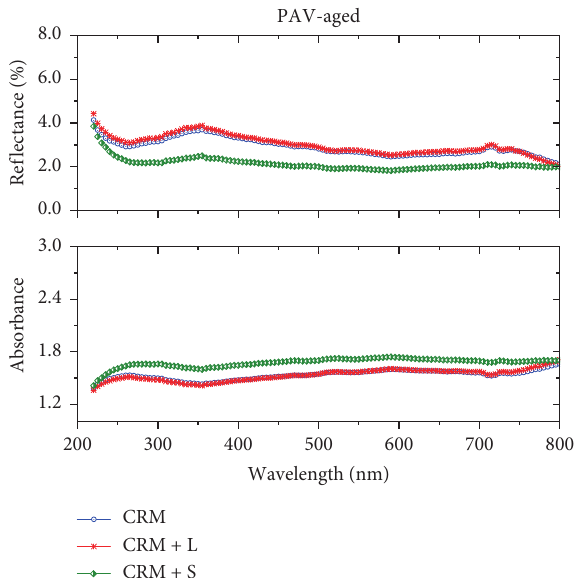
Figure 3: Reflectivity and absorbance of aged warm asphalt binders.